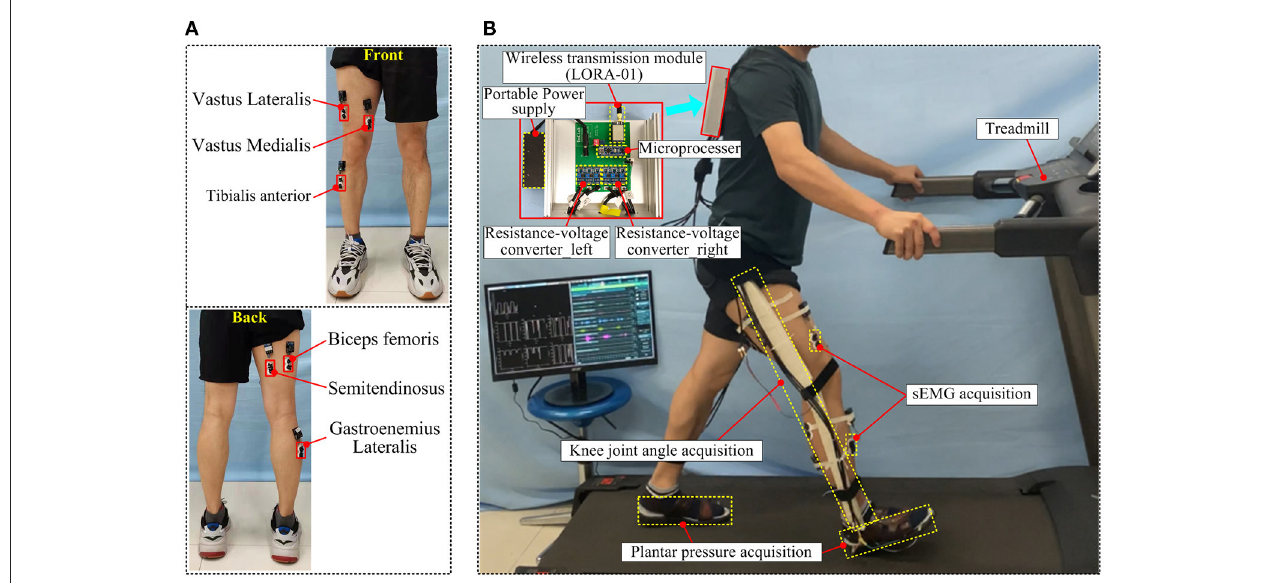
FIGURE 8 | The gait information acquisition device, (A) the installation position of the sEMG sensor, (B) the wearing effect and information acquisition process of the gait information acquisition device.